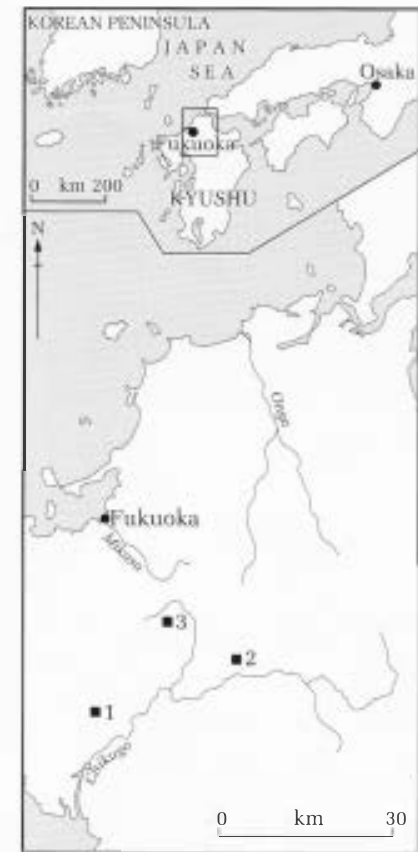
Figure 1 Northern Kyushu, showing the location of three cemeteries of the early Middle Yayoi phase mentioned in the